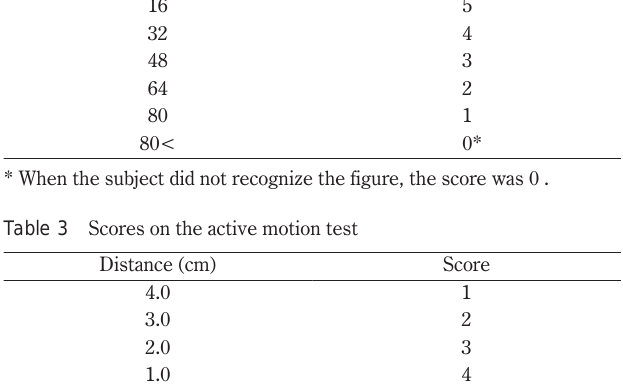
Figure 2 Experimental setting for the depth perception test: Lateral direction. Subjects indicated both marker-c positions when they were equidistant from marker-a (left) and -b